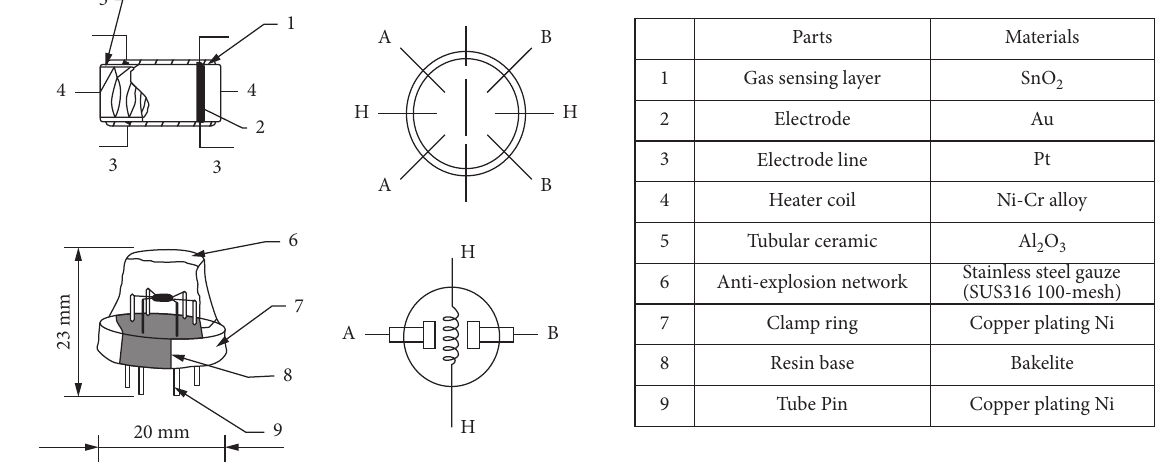
Figure 2: MQ-3 gas sensor parts.